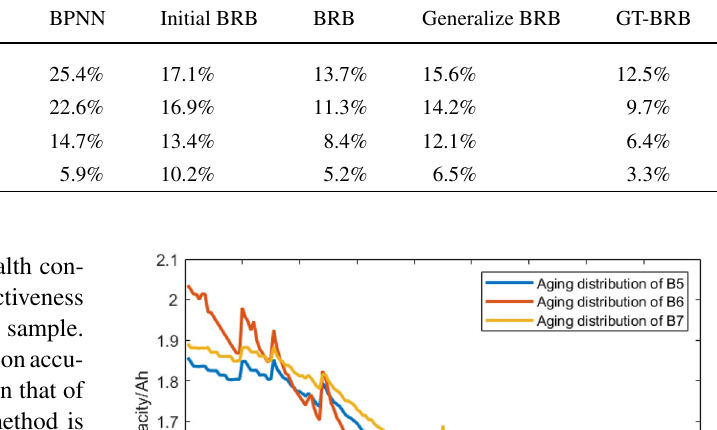
Table 4 The MRE of different conditions